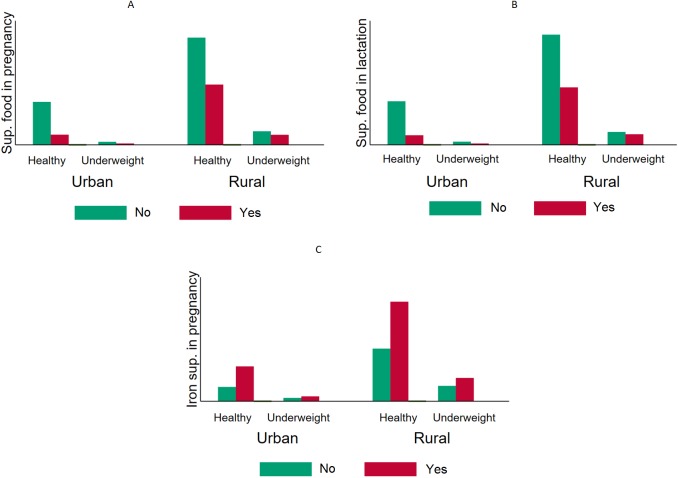
Comparative prevalence of underweight by supplementation intake during pregnancy and lactation stratified by type of residency in Timor Leste (2009–2010).The overall prevalence of having underweight (WFA < 2 SD) children was higher among mothers who did not take supplementary food during pregnancy (A) and lactation (B). The same pattern was observed when the sample was stratified into urban and rural areas. In the chi-square tests, iron intake (C) did not show any significant decrease in the probability of being underweight.